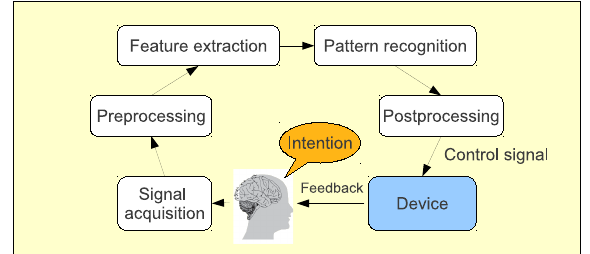
Figure 9. General scheme of a classical brain-computer interface (BCI): first of all, the subject performs a specific mental task in order to produce a signal of interest in his brain; then, this signal is acquired and generally pre-processed in order to get rid of different